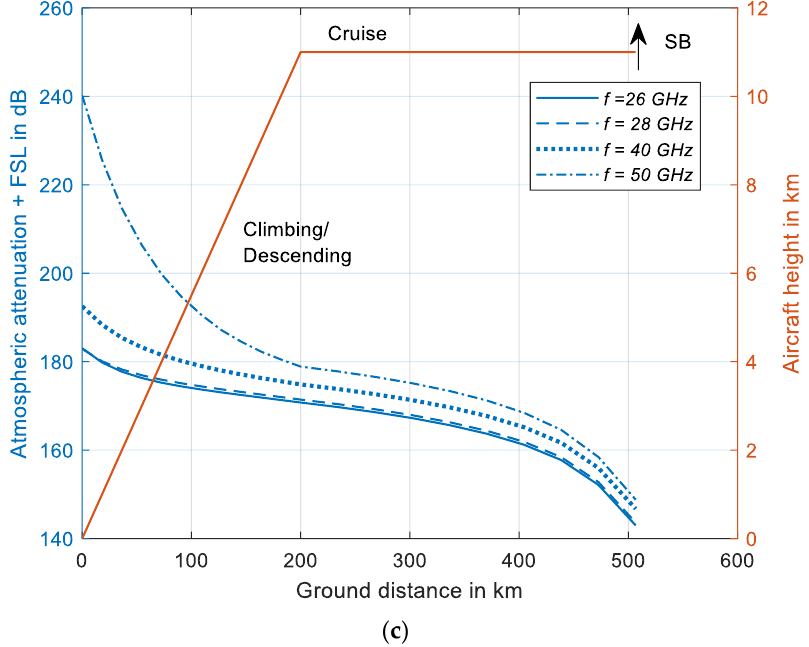
Figure 12. Flight signal attenuation performance for 5G mm-wave frequencies from 26 up to 50 GHz in dB: ( a ) atmospheric gaseous attenuation, ( b ) free-space loss (FSL), ( c ) combined atmospheric gaseous attenuation and FSL performance.